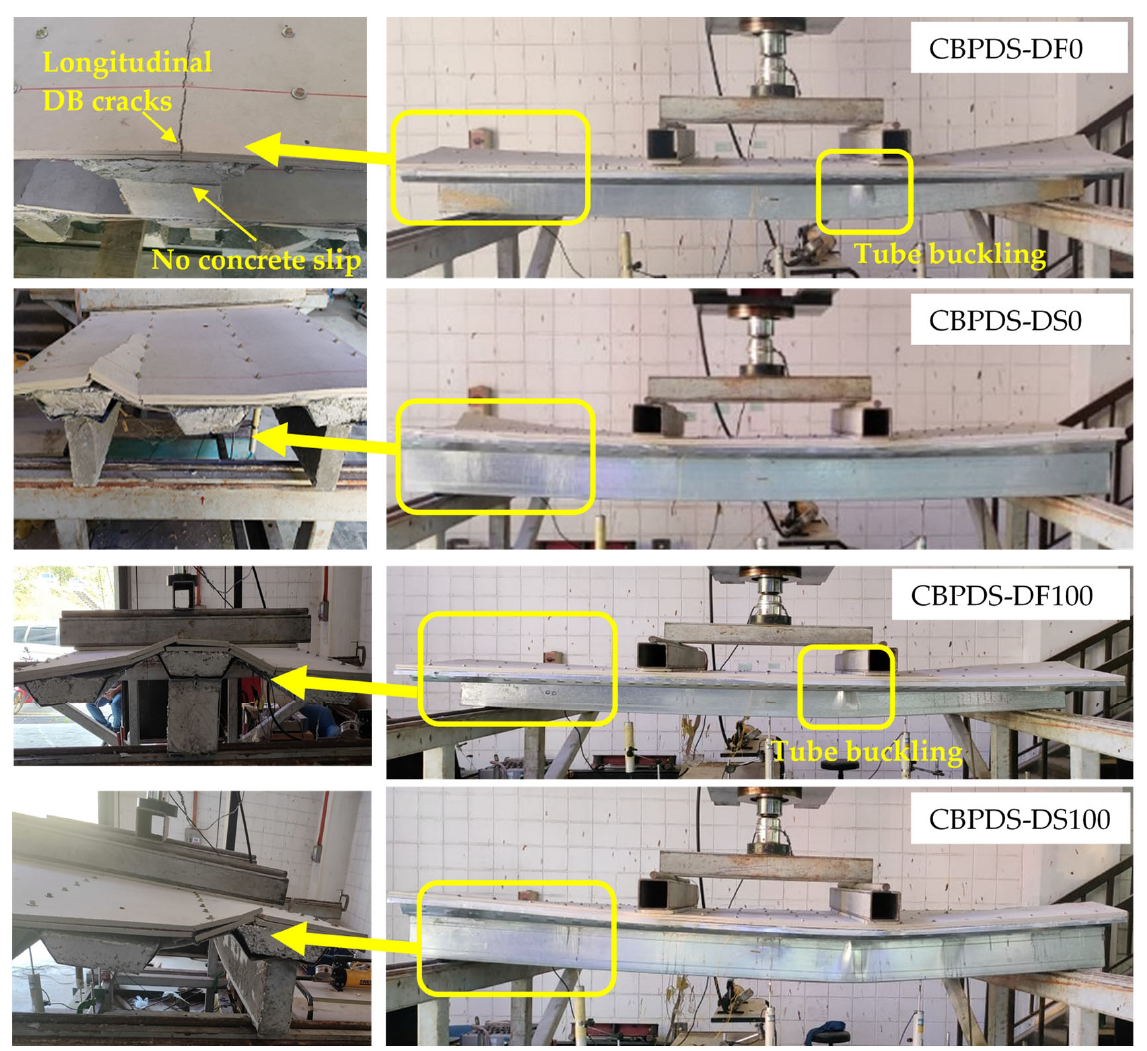
Figure 8. Bending behavior of the CBPDS double- fi lled and double separate specimens.